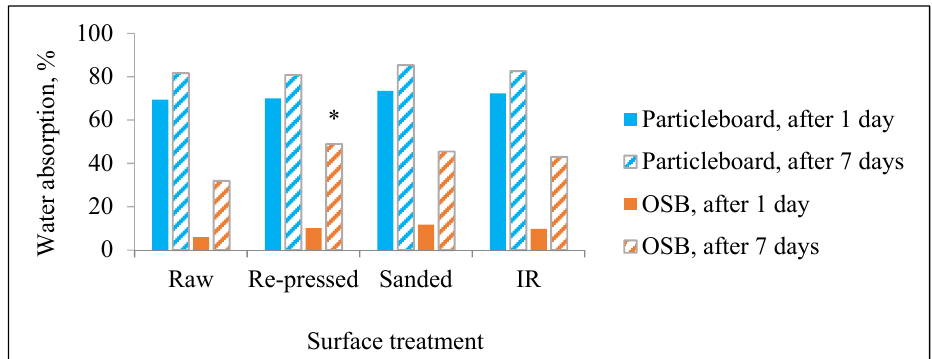
Figure 4. Water absorption of tested particleboard and OSB panels after 1 and 7 days of immersion in water. * Difference statistically significant in comparison with raw particleboard or OSB panel according to the Tukey test at α = 0.05 significance level.